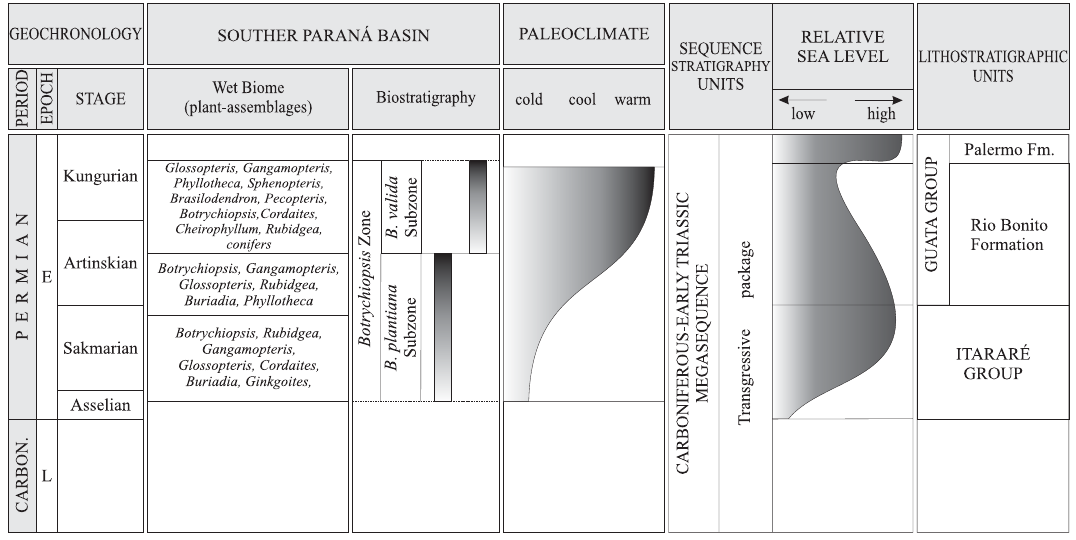
Fig. 9 – Botrychiopsis Zone and related plant-assemblages, palaeoclimate, sequence stratigraphy units, relative sea level and litostrati- graphic units of Early Permian in Southern Paraná Basin,